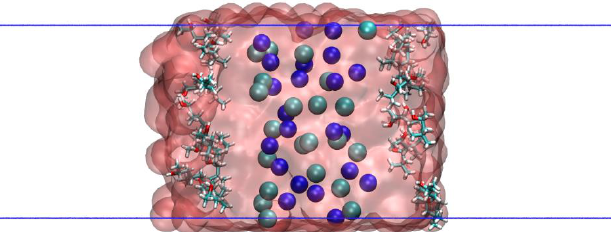
Figure 1. Initial configuration of a system with 1 M NaCl and 20 MIBC molecules. Na and Cl ions are represented respectively by blue and green spheres. MIBC is concentrated at the left and right interfaces.